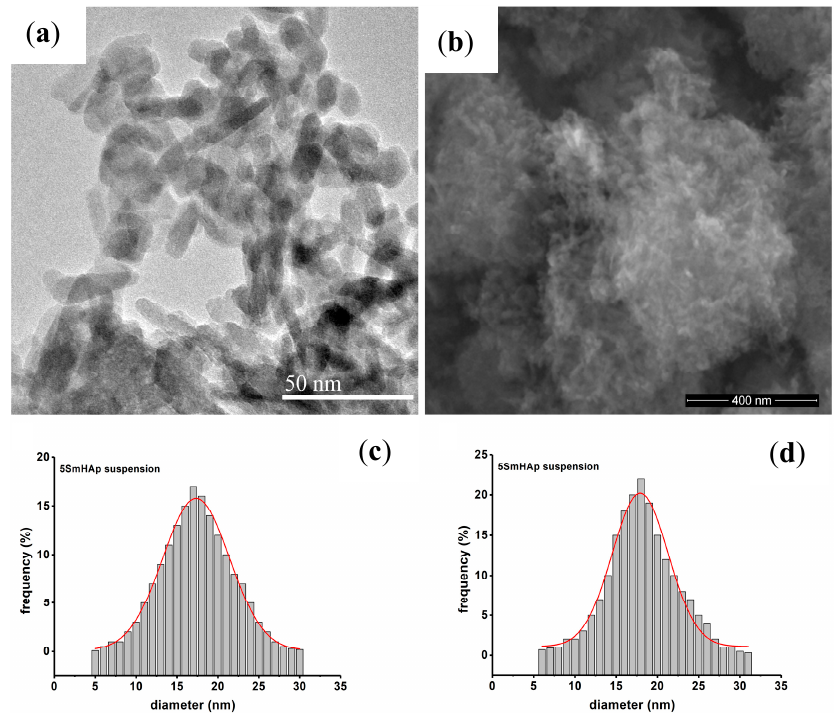
Figure 4. TEM ( a ) and SEM ( b ) micrographs of 5SmHAp suspension. Particle size distribution of 5SmHAp suspension obtained by TEM ( c ) and SEM ( d ) studies.